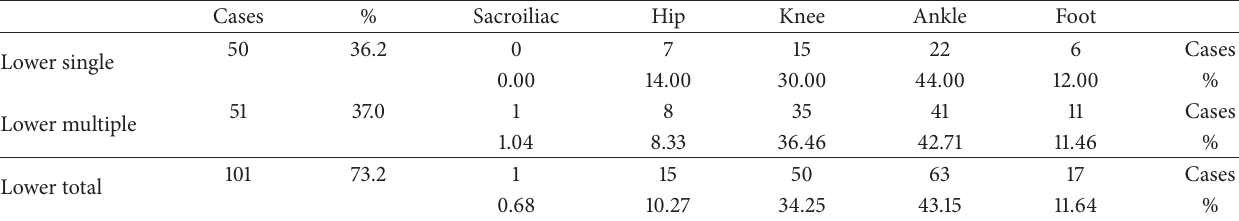
Table 2: Lower limb joints affected by DEH reported in the literature.